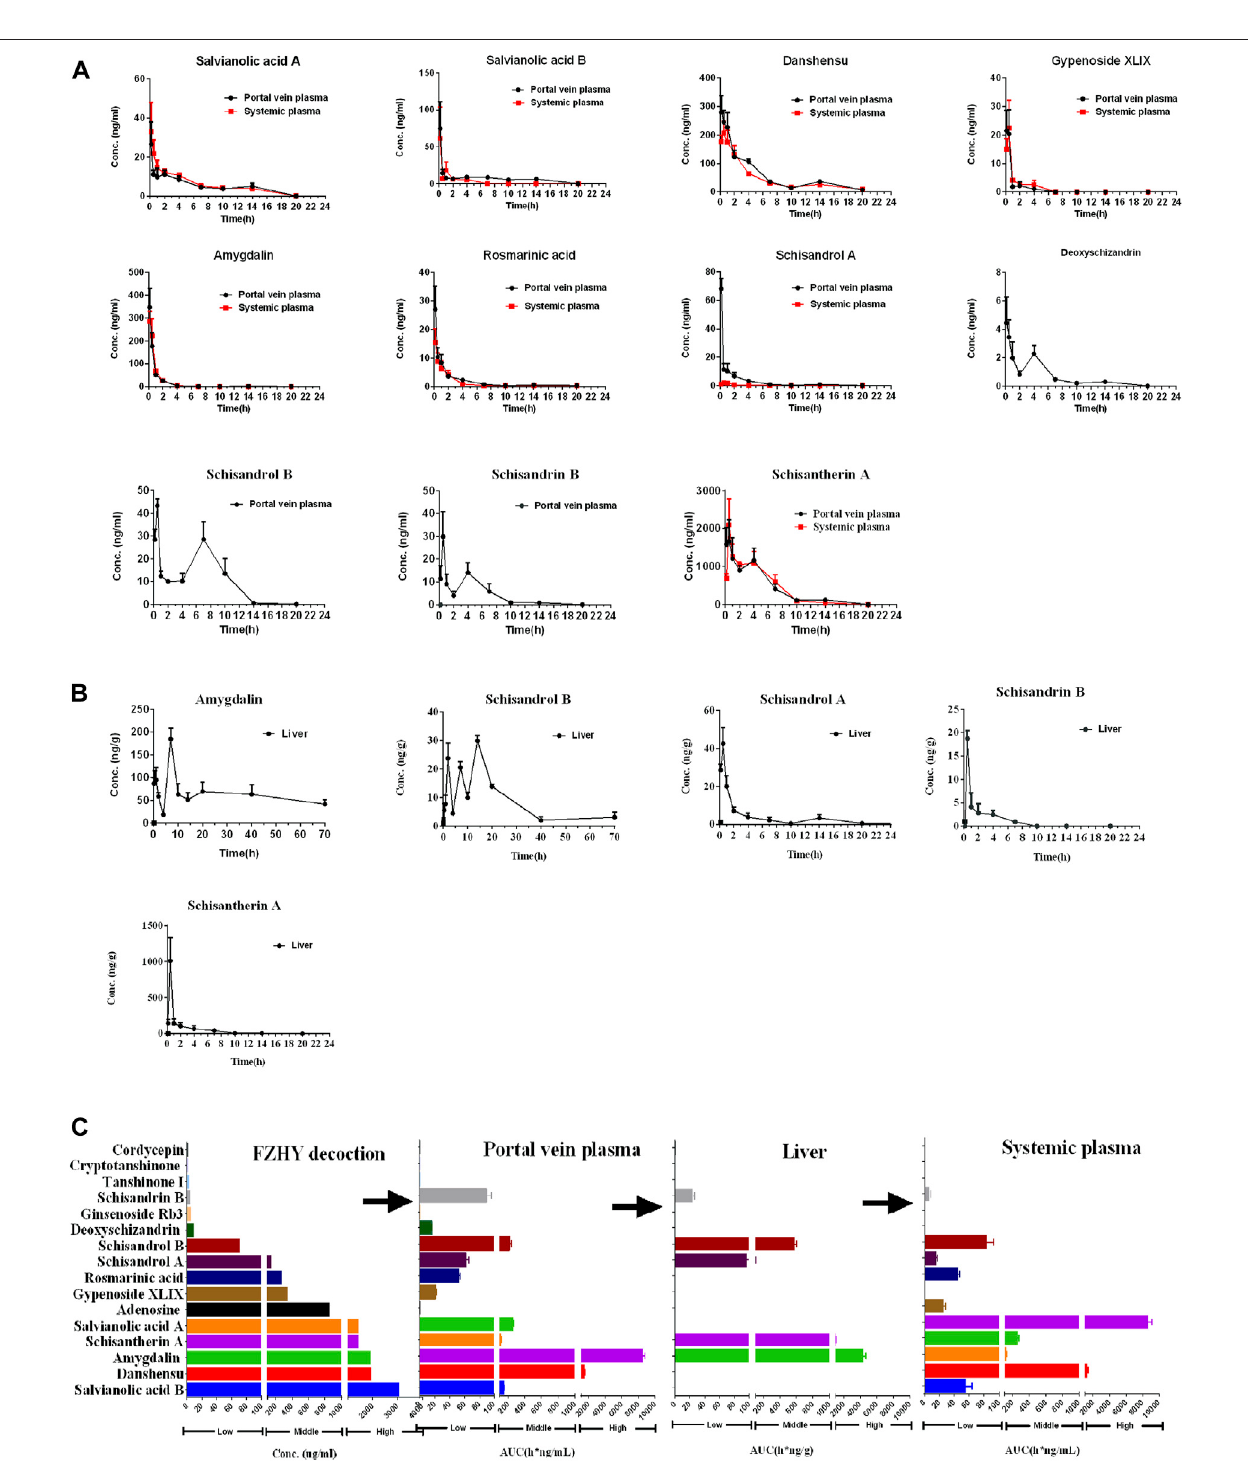
FIGURE 1 | Quantitative analysis of FZHY decoction and FZHY biological samples. Concentration – time curves of compounds in the plasma (A) and liver (B) after oral administration ofFZHY decoction (20 g/kg) in rats ( n (cid:2) 5). (C) Summary ofthecontentsand AUCofcompounds in theFZHY decoction orFZHYbiological samples.